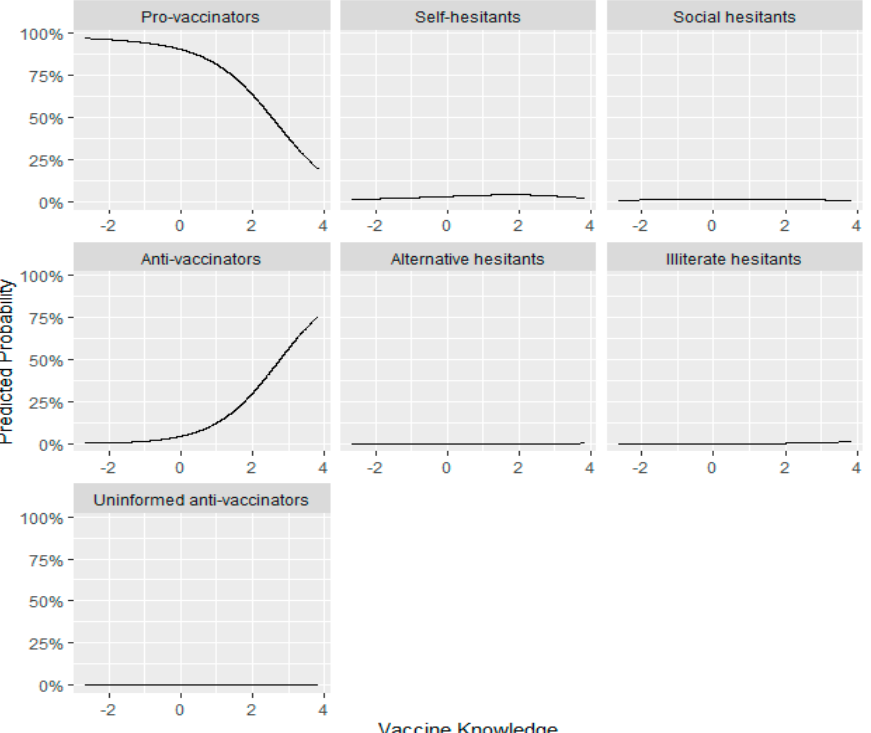
Figure A5. Marginal Effects Multinomial Logistic Regression. Vaccine Knowledge.